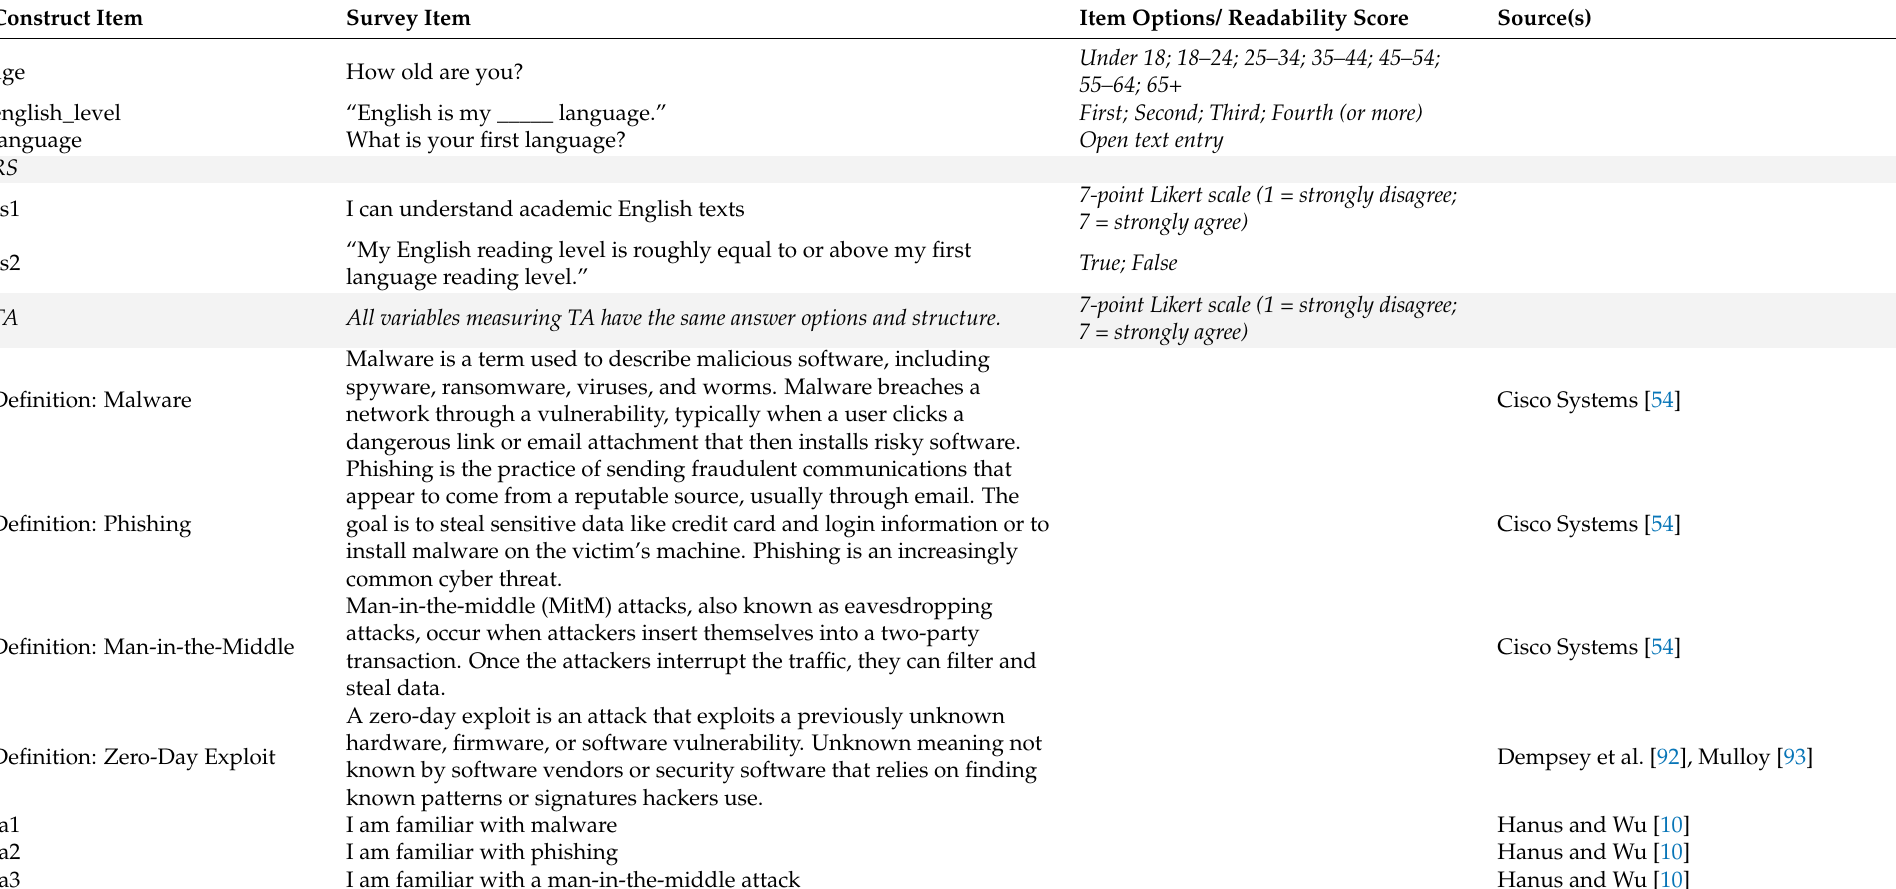
Table A1. Overview of all questionnaire